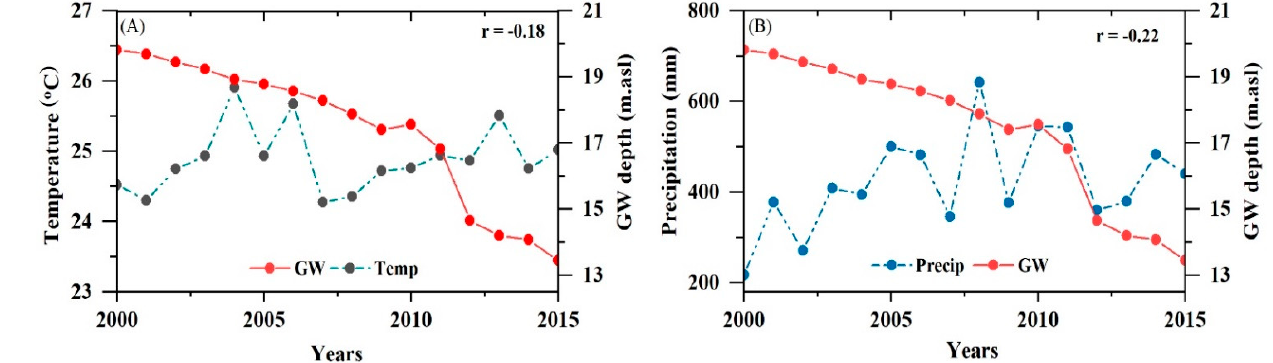
Figure 5. Spatio-temporal trend analysis of average groundwater trends with temperature ( A ) and precipitation ( B ) in 2000–2015. precipitation ( B ) in 2000–2015. Table 4. Statistics of climatic factors and their correlation with Table 4. Statistics of climatic factors and their correlation with DWT.